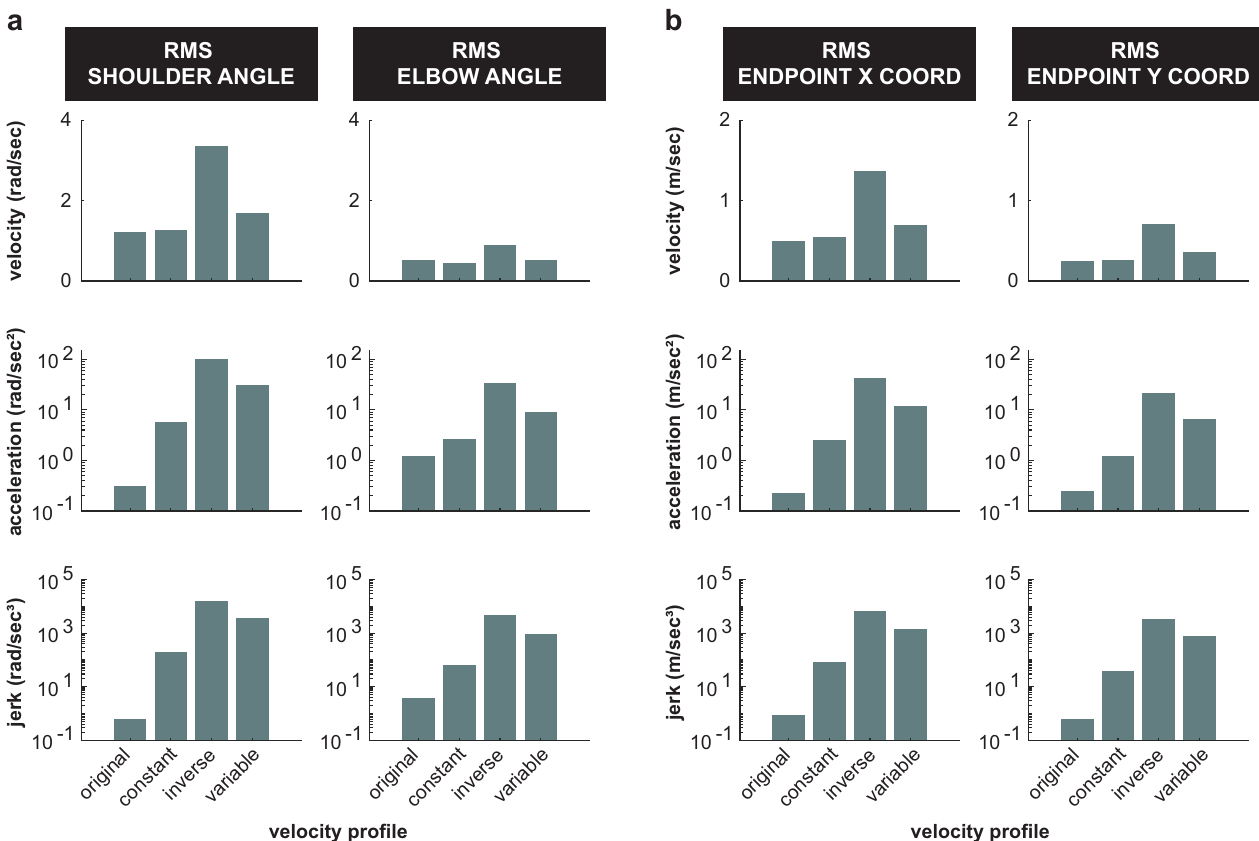
Fig 13. RMS of temporal motion features in Experiment 2. All 4 velocity profiles’ RMS of velocity (rad/s), acceleration (rad/s 2 ), and jerk (rad/s 3 ) for 1 cycle of motion in (a) joint coordinates, and (b) endpoint coordinates.